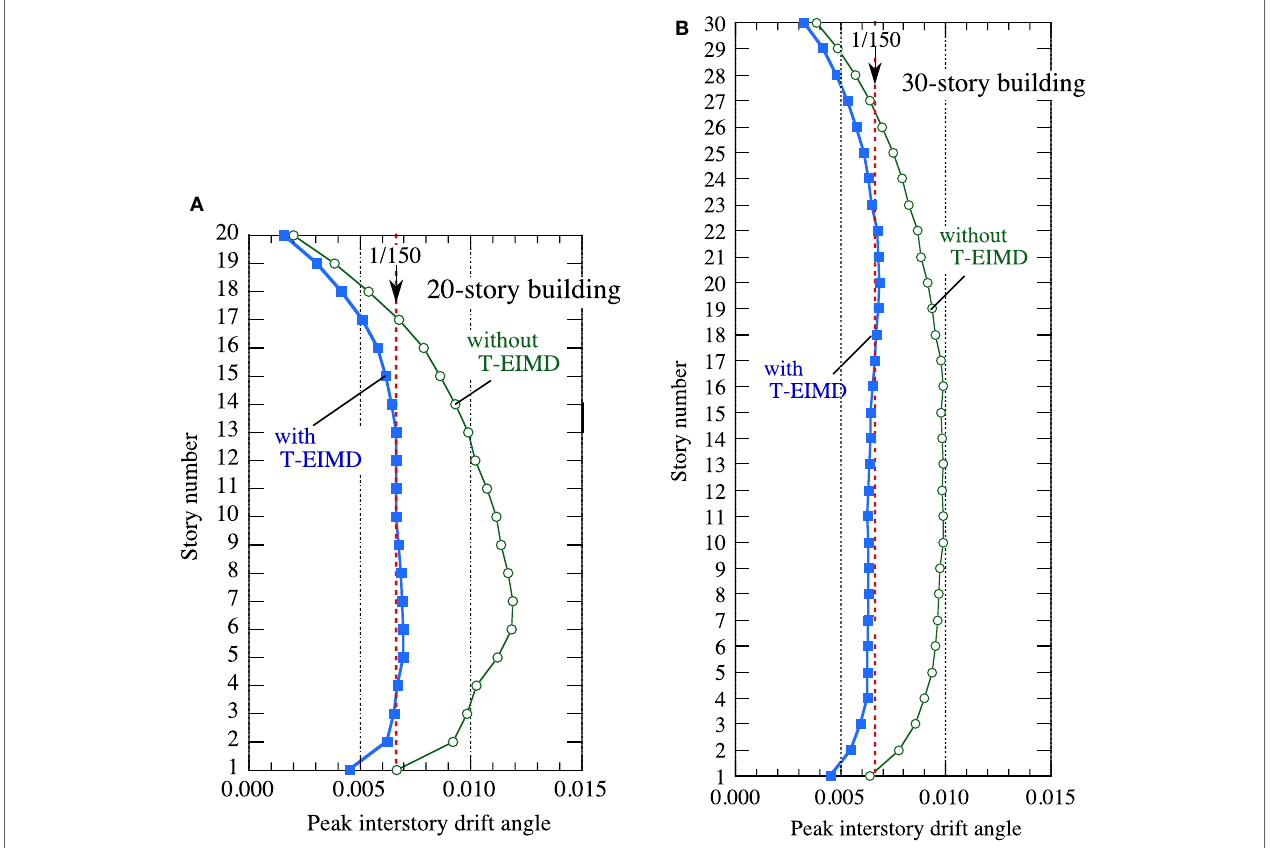
FIGURE 13 | Mean peak story drift angles in buildings without tuned electromagnetic inertial mass dampers (T-EIMDs) and buildings with T-EIMDs designed for maximum story drift angle of 1/150 . (A) 20-story building, and (B) 30-story building.